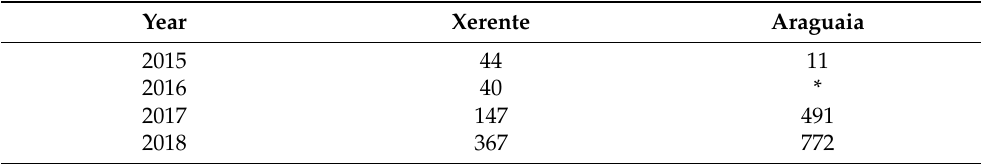
Table 2. The number of Prescribed burning (PB) performed in the scope of the Integrated Fire Management (IFM) program figure 2015 to 2018 in each study area (Xerente and